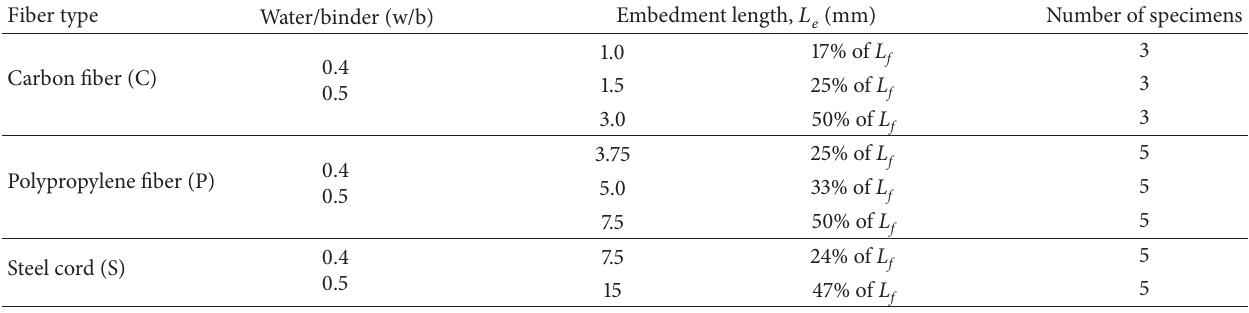
Table 2: Parameters for testing.